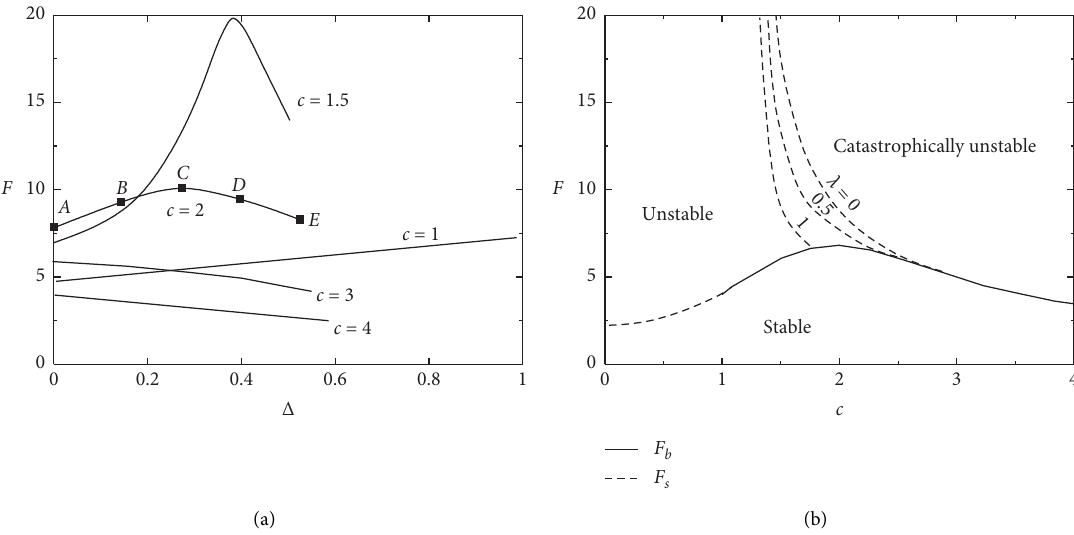
Figure 3: (a) Load-displacement curves of the symmetric portal frame with h � 1, d � 0, λ � 0; (b) design curves of the symmetric portal frame showing the change of F b and F s against the span length of the frame c [11].